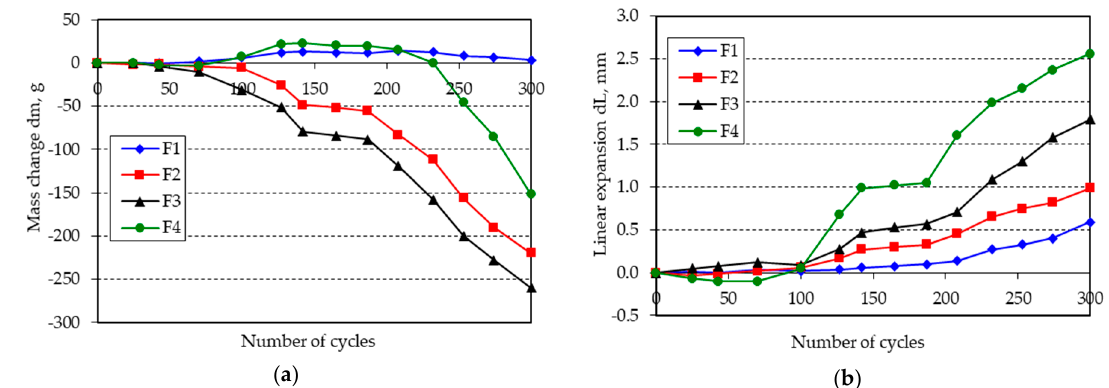
Figure 6. ( a ) Mass change; ( b ) linear expansion of specimens F1–F4 following freezing and thawing